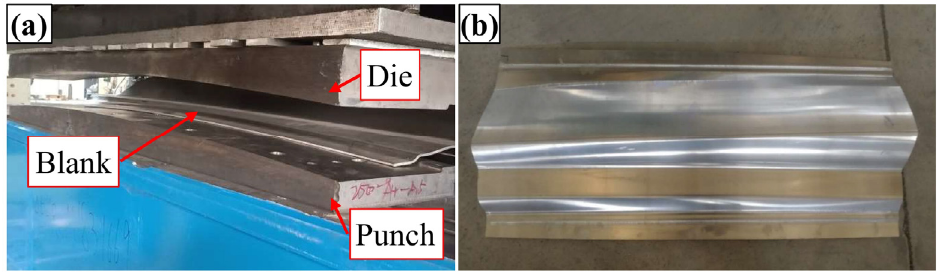
Figure 12. ( a ) The tools for the forming experiment; ( b ) test